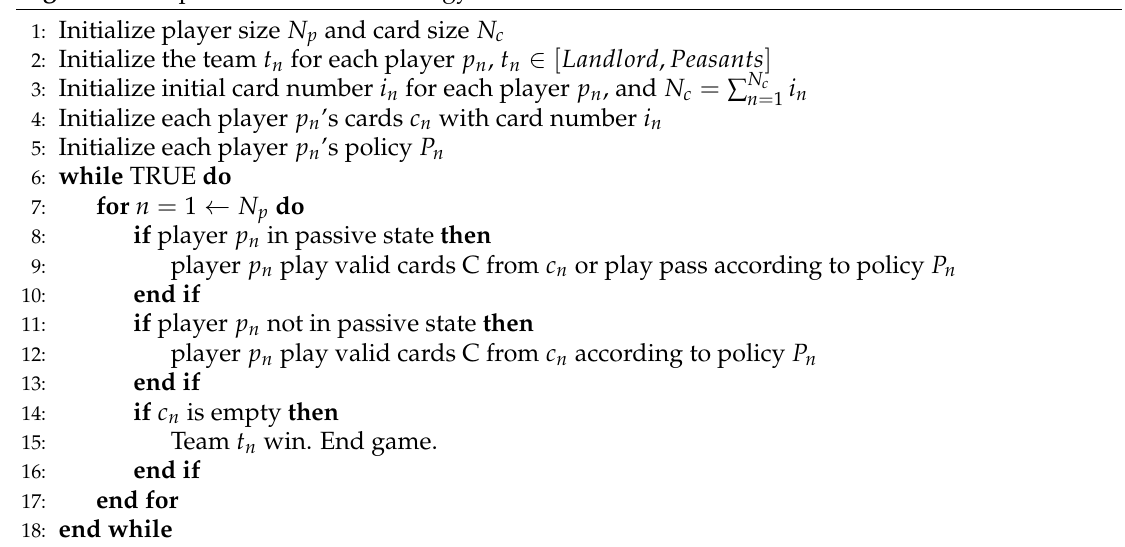
Algorithm 1 Optimal simulation strategy for